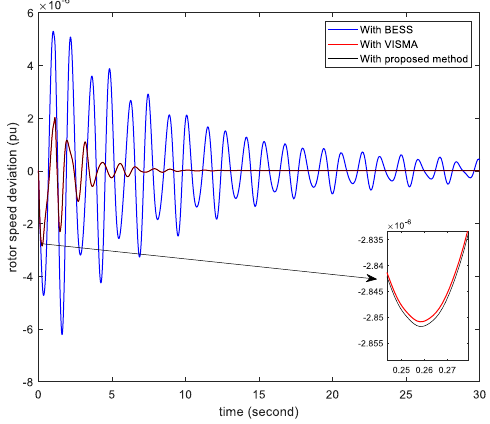
Figure 10. Rotor speed responses of G3.